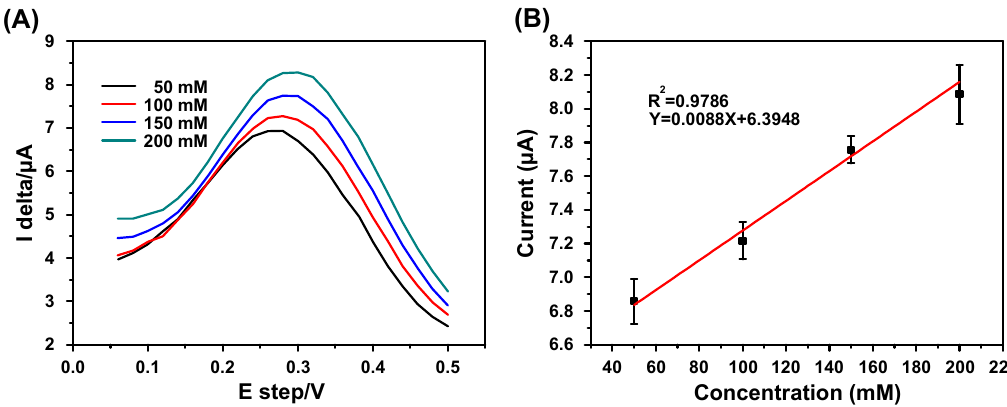
Figure 6. Na + detection using square-wave voltammetry (SWV): ( A ) cyclic voltammograms (100 mV/s) for various Na + concentrations (50–200 mM); ( B ) linear calibration curve representing the relation between the stable oxidization peak current and concentration; scanning range: 0–0.5 V, pulse height 100 mV, pulse width 200 ms, step height 20 mV, N = 3.